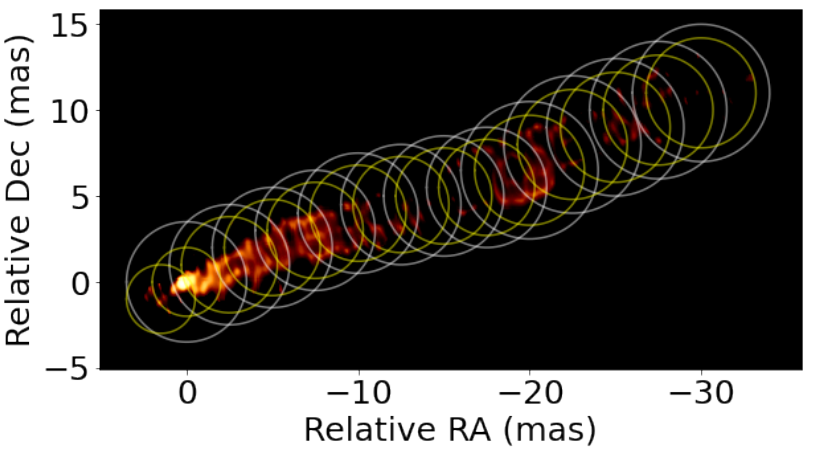
Figure 2. The averaged image of 48 final images (see Figure 3) and regions of the window setting. White circles represent areas where pixel values are restored during image reconstruction. Flux densities generated outside the yellow circles by the image reconstruction are considered noise, and pixel values are set to